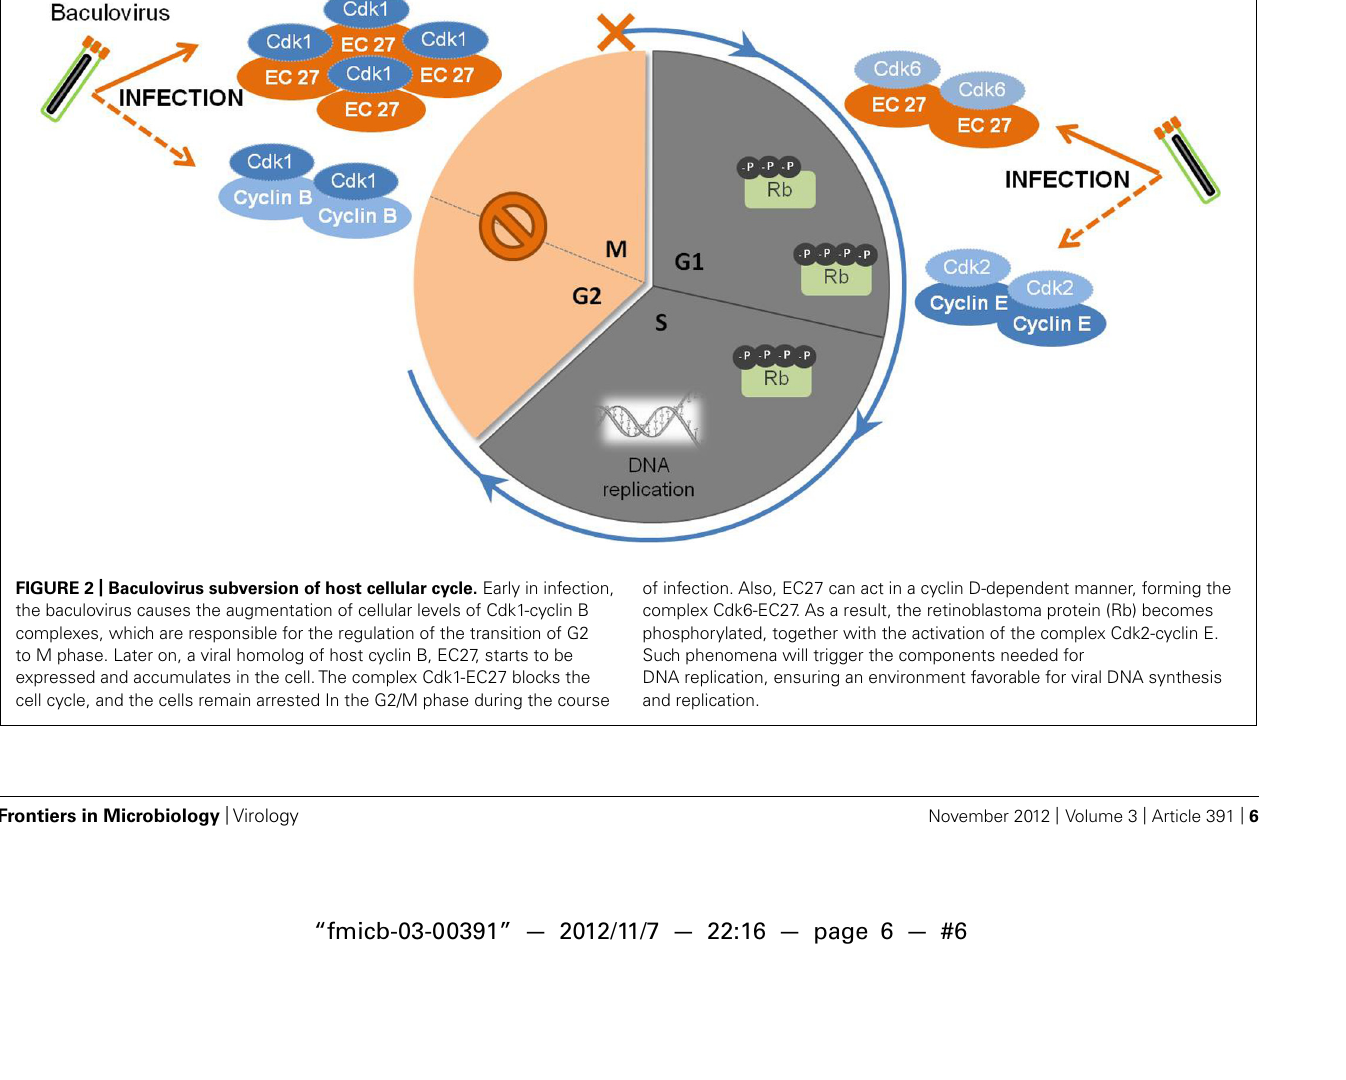
FIGURE 2 | Baculovirus subversion of host cellular cycle. Early in infection, the baculovirus causes the augmentation of cellular levels of Cdk1-cyclin B complexes, which are responsible for the regulation of the transition of G2 to M phase. Later on, a viral homolog of host cyclin B, EC27, starts to be expressed and accumulates in the cell.The complex Cdk1-EC27 blocks the cell cycle, and the cells remain arrested In the G2/M phase during the course